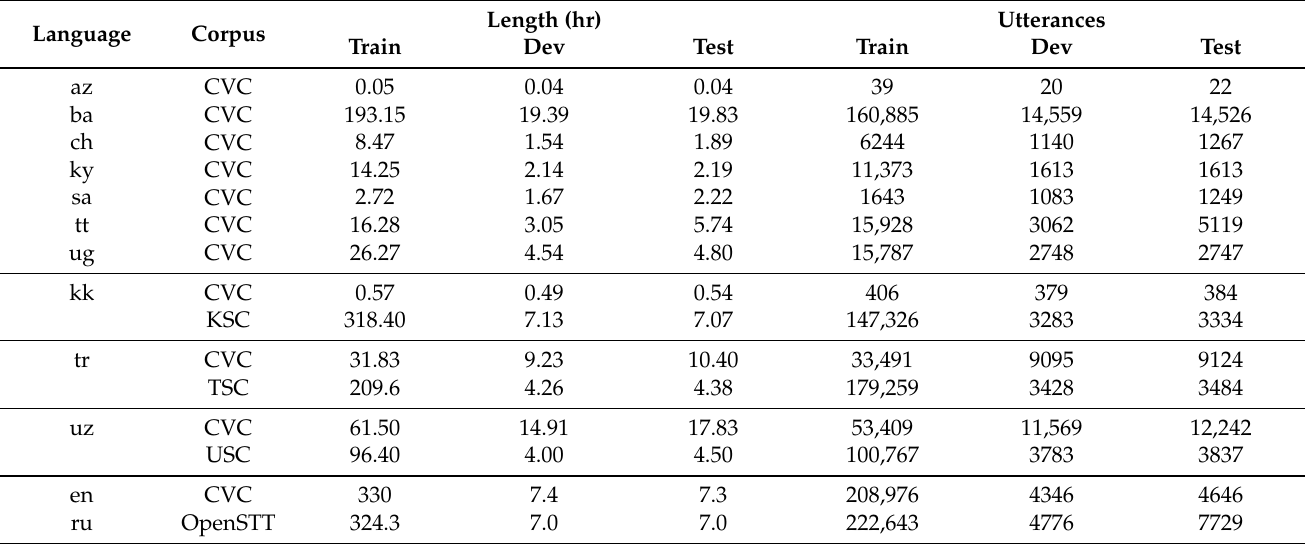
Table 3. Statistics for the training (Train), development (Dev), and test (Test) sets of CVC, OpenSTT , KSC, TSC, and